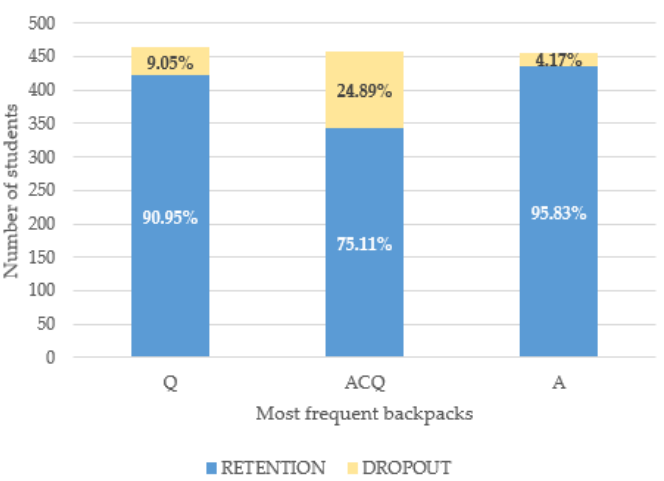
Figure 6. Proportion of educational trajectories, according to the BPPM model, that includes each one of the three most frequent backpacks (Q, ACQ and A) and end either in RETENTION or in DROPOUT.